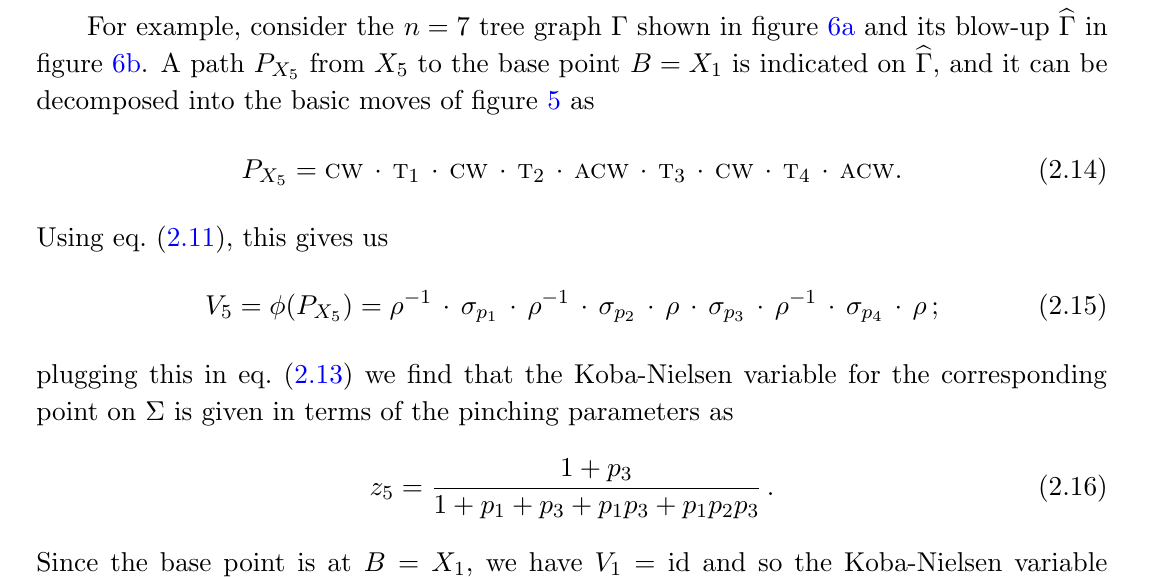
from X 5 to B is indicated with the blue 5